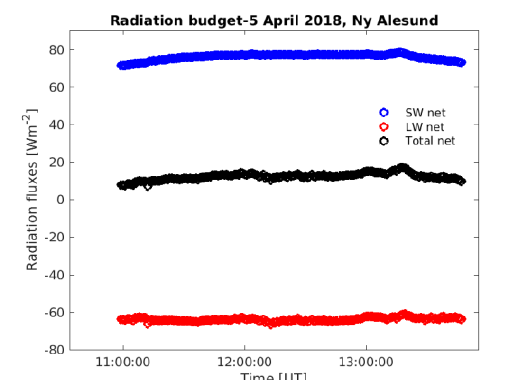
Fig 4: Net radiation budget on ground level at Ny- Ålesund, 5 April